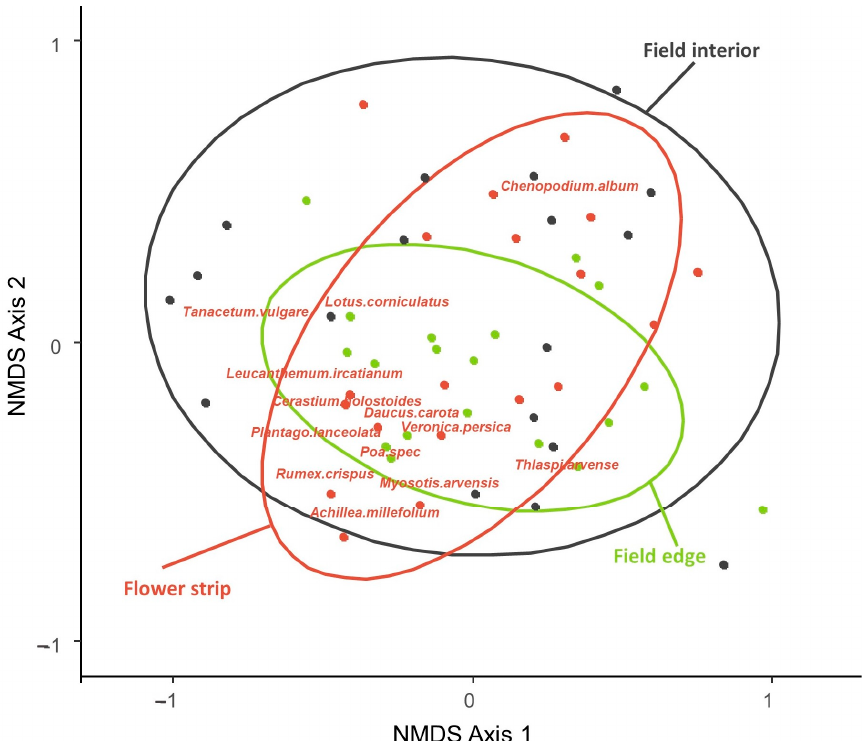
Figure 5. NMDS plot with Bray–Curtis distances, abundance data Hellinger-transformed, and 85% confidence interval for field location (k = 3, stress = 0.159). Only species with a significant ecological preference for field locations are shown (in red: flower strip; in green: field edge; in yellow: flower strip and field edge; statistical results in Table S4).